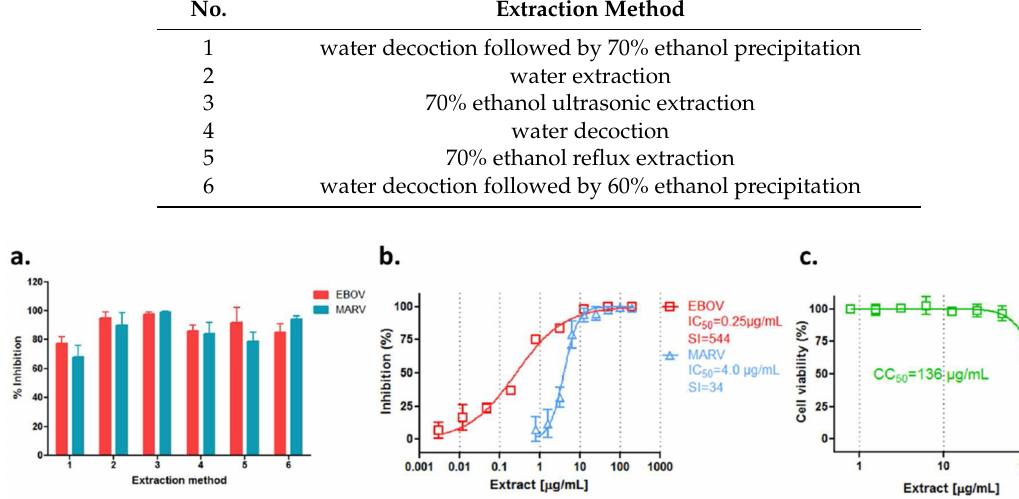
Figure 2. Anti-filovirus activities of R. rosea extracts. ( a ) Six extracts from R. rosea prepared by various extraction methods (Table 1) were evaluated against pseudotyped EBOV infection at 12.5 µ g/mL; ( b ) The in vitro dose-response curves of R. rosea extract are shown against HIV/EBOV ( (cid:3) , red) and HIV/MARV ( ∆ , blue) pseudovirion infections and ( c ) in cell toxicity assay ( (cid:3) , green) in A549 cells. Data are means ± SD ( n = 3) from three independent